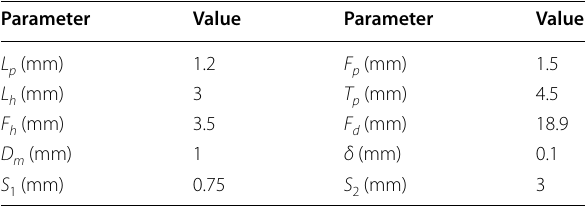
Table 1 Thermophysical properties of heat sink materials